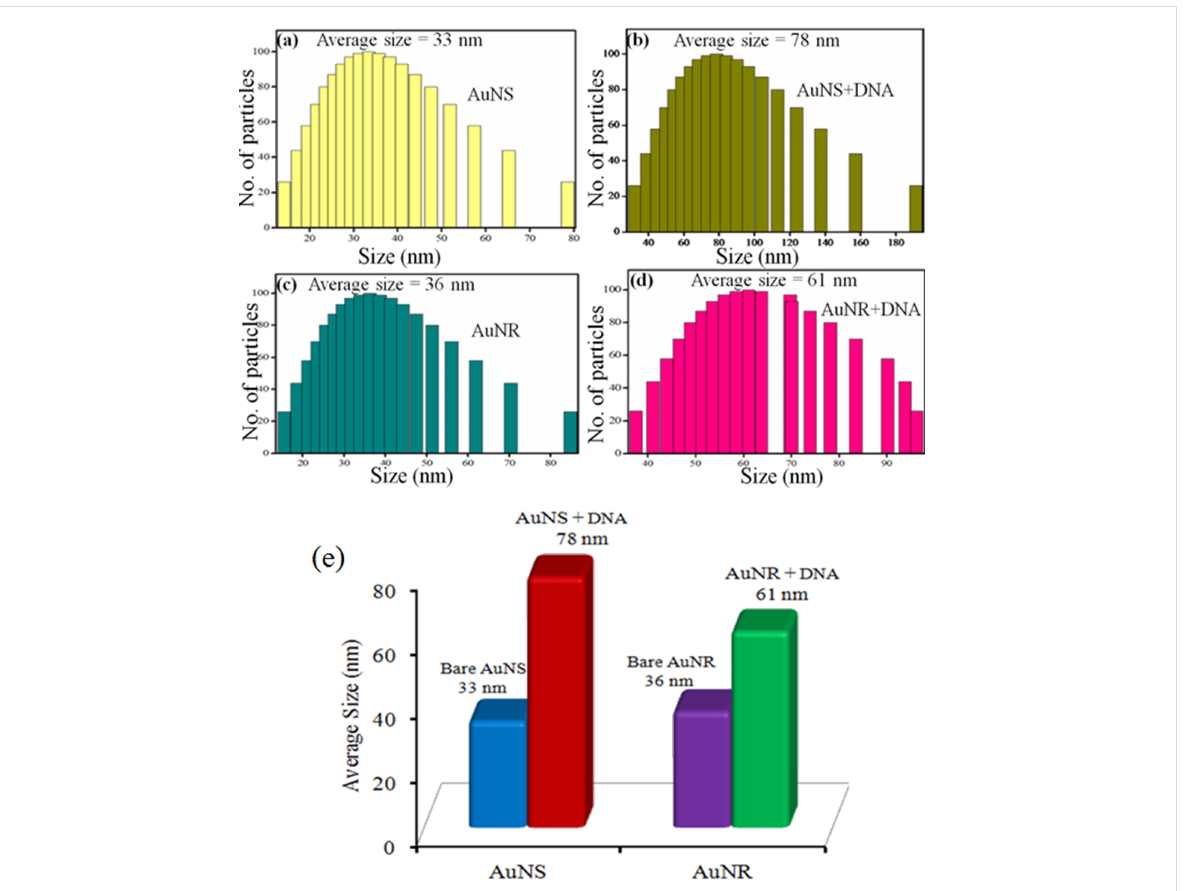
Figure 4: Dynamic light scattering particle size distribution of bare and DNA modified (a,b) AuNS-1, (c,d) AuNRs and (e) their comparative average diameter